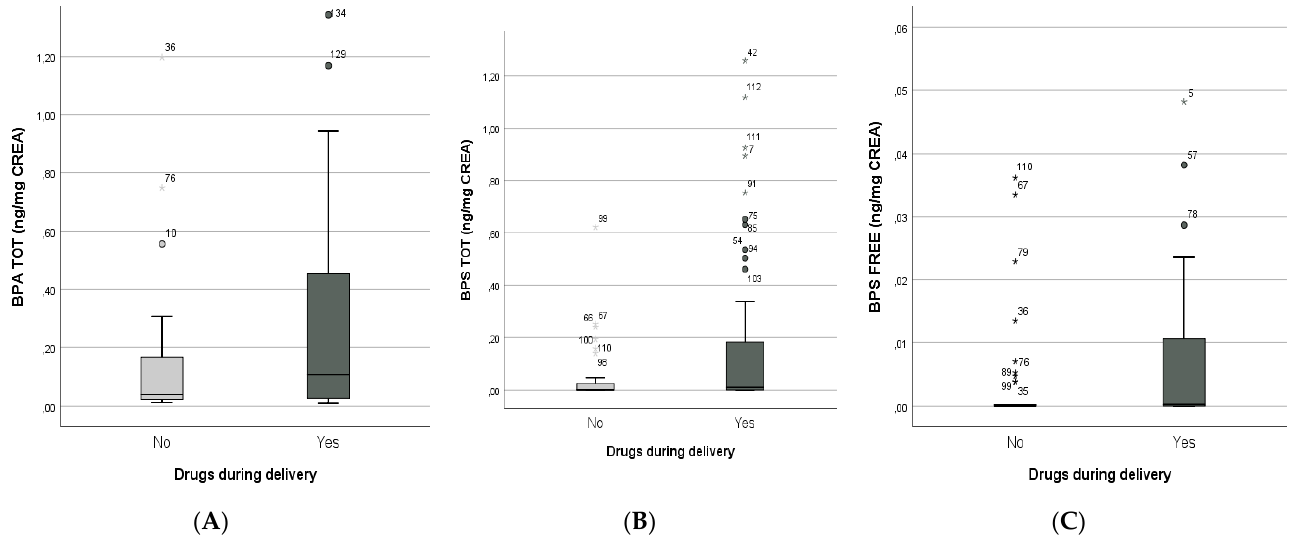
Figure 3. Correlations between drugs administered during delivery and BPA total ( A ), BPS total ( B ), and free BPS ( C ) concentrations in newborns.